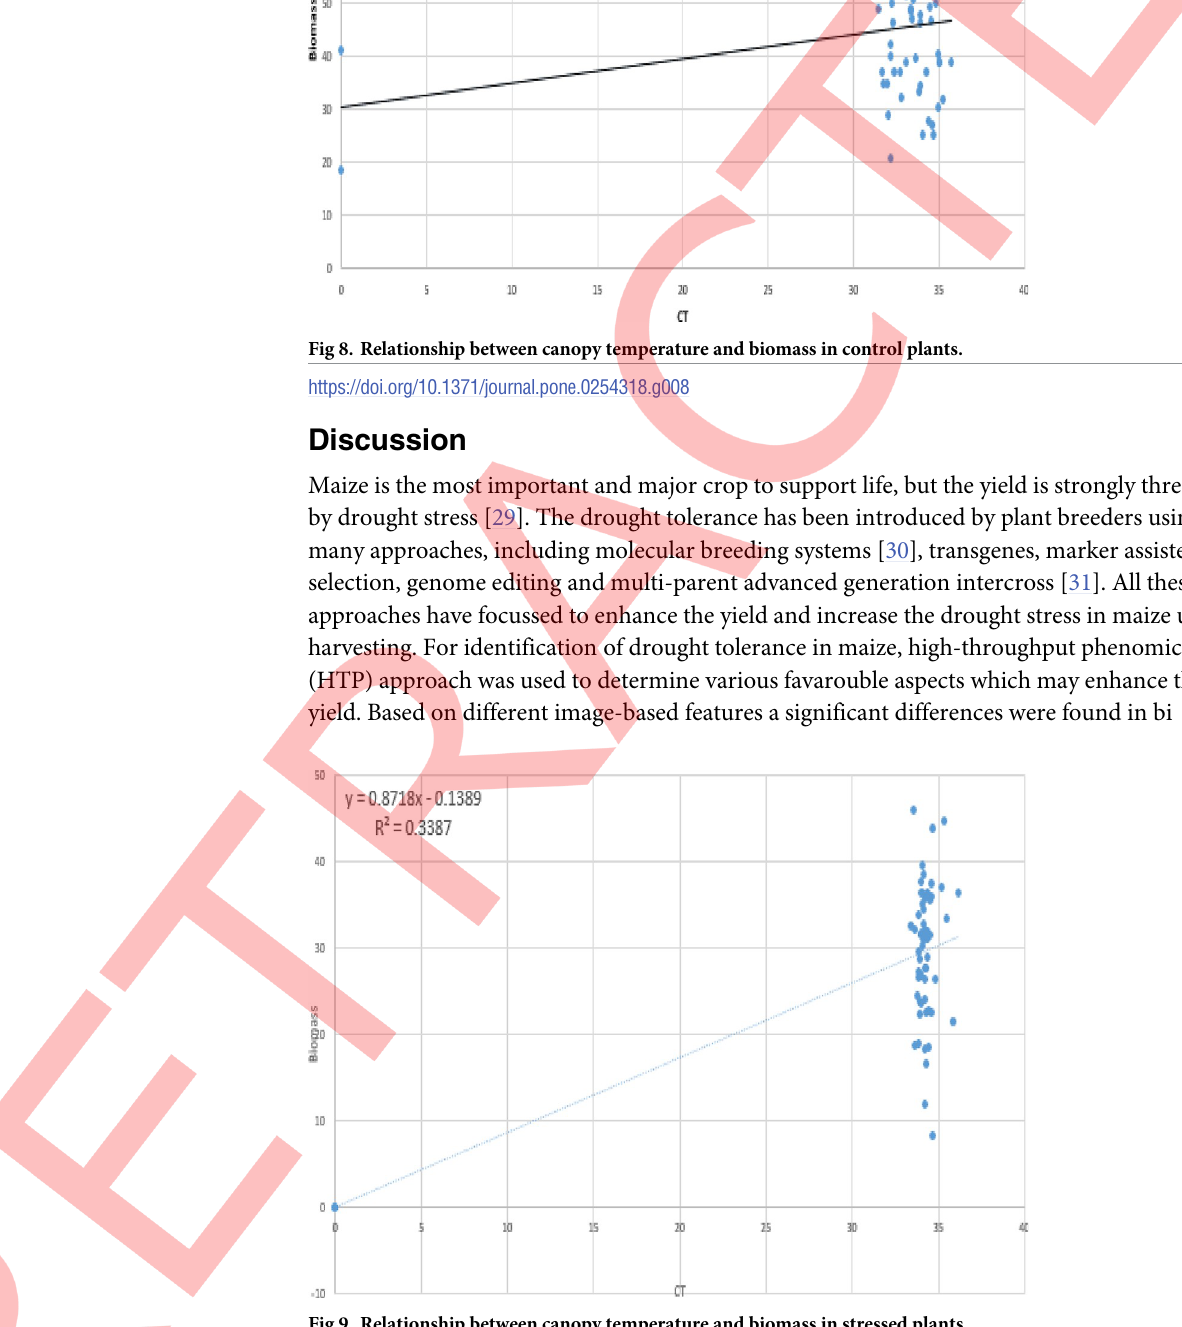
Fig 9. Relationship between canopy temperature and biomass in stressed